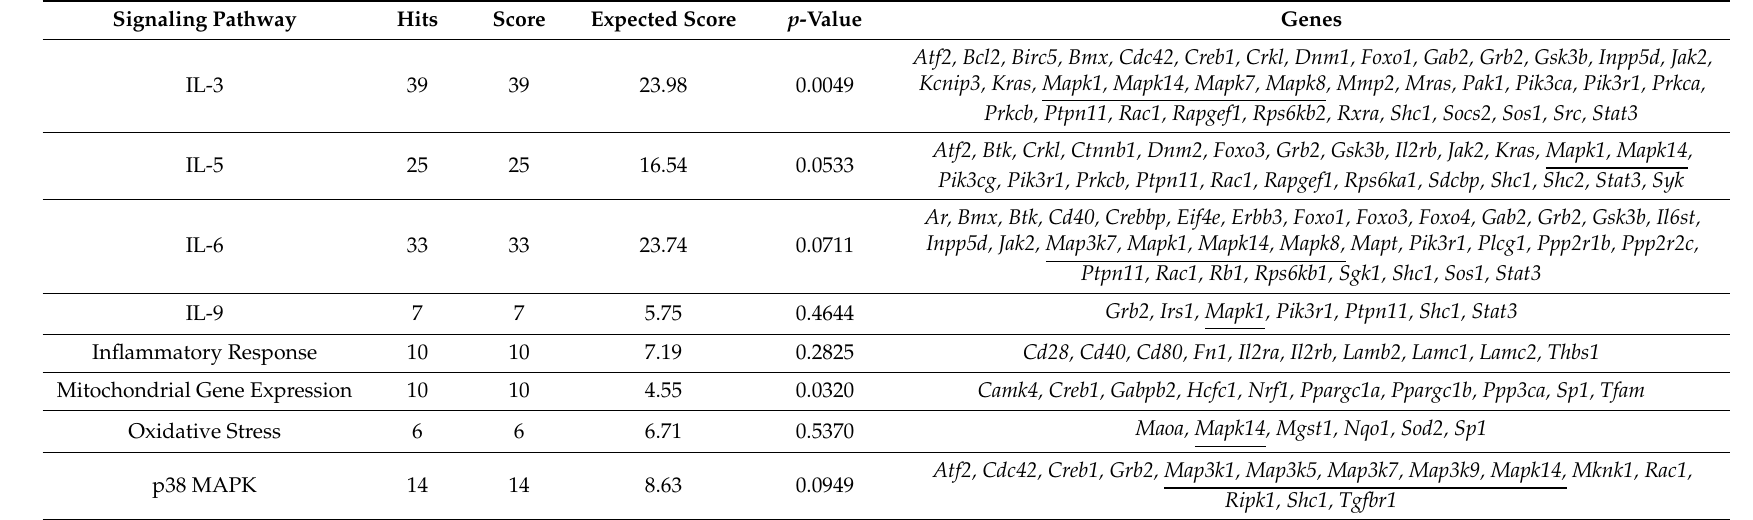
Table 2. Renin angiotensin system (RAS) mediated miR-690 activation significantly a ff ects inflammatory and cell-stress signaling pathways. Significantly a ff ected pathways in Agt Tg compared to Wt mice white adipose tissue (WAT) and potential gene targets of